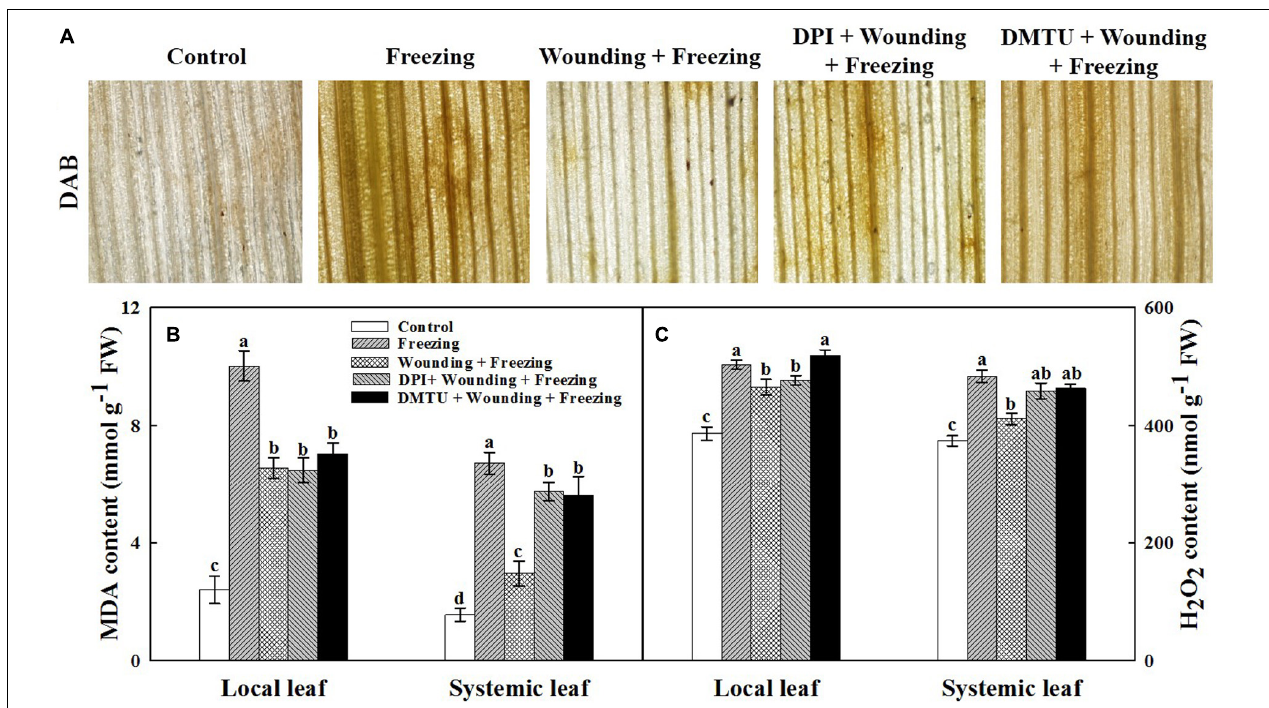
FIGURE 4 | Effects of mechanical wounding on the accumulation of H 2 O 2 and content of malondialdehyde in the local and the systemic leaves of wheat under freezing stress. DAB staining (A) , Malondialdehyde (MDA) content expressed in mmol g − 1 FW (fresh weight) (B) and H 2 O 2 content expressed in nmol g − 1 FW (C) . The local (fifth) leaves were separately pre-treated with distilled water, 5 mM DMTU or 100 µ M DPI prior to wounding. At 10 days after wounding, the seedlings were exposed to freezing stress for 24 h. After 24 h recovery, 3,3-diaminobenzidine (DAB) staining was used to detect the presence of H 2 O 2 in systemic leaves. Dark brown spots represent localized H 2 O 2 accumulation. The leaves were also collected immediately to determine the contents of H 2 O 2 and MDA. Data are mean values ± SD of three independent replicates. Means denoted by different letters indicated significant difference at P < 0.05 according to Tukey’s